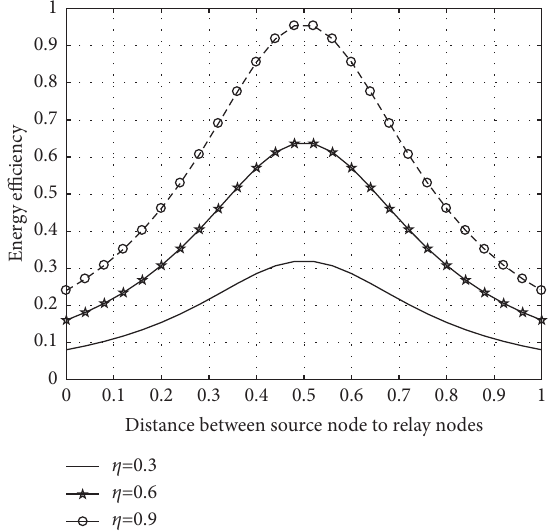
Figure 7: Energy efficiency against relay location.